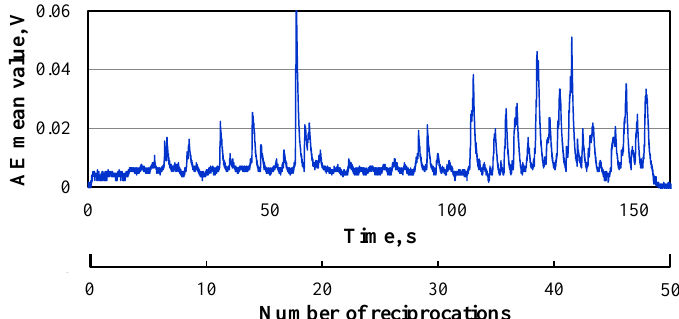
Figure 9. Changes in the frictional force and the contact electrical resistance ( t = 0.2 mm, Ag plating 1 µm, v = 200 mm/min).